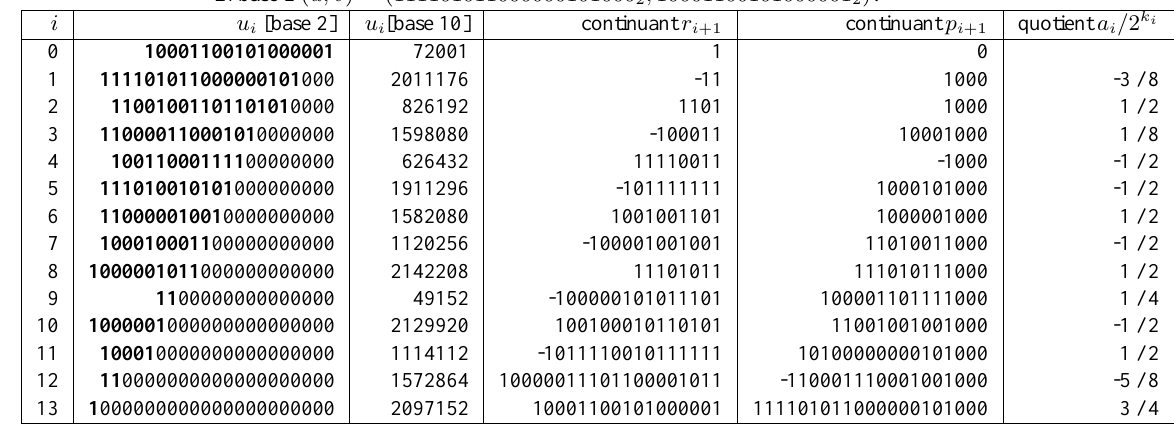
Fig. 1: An execution of the LSB